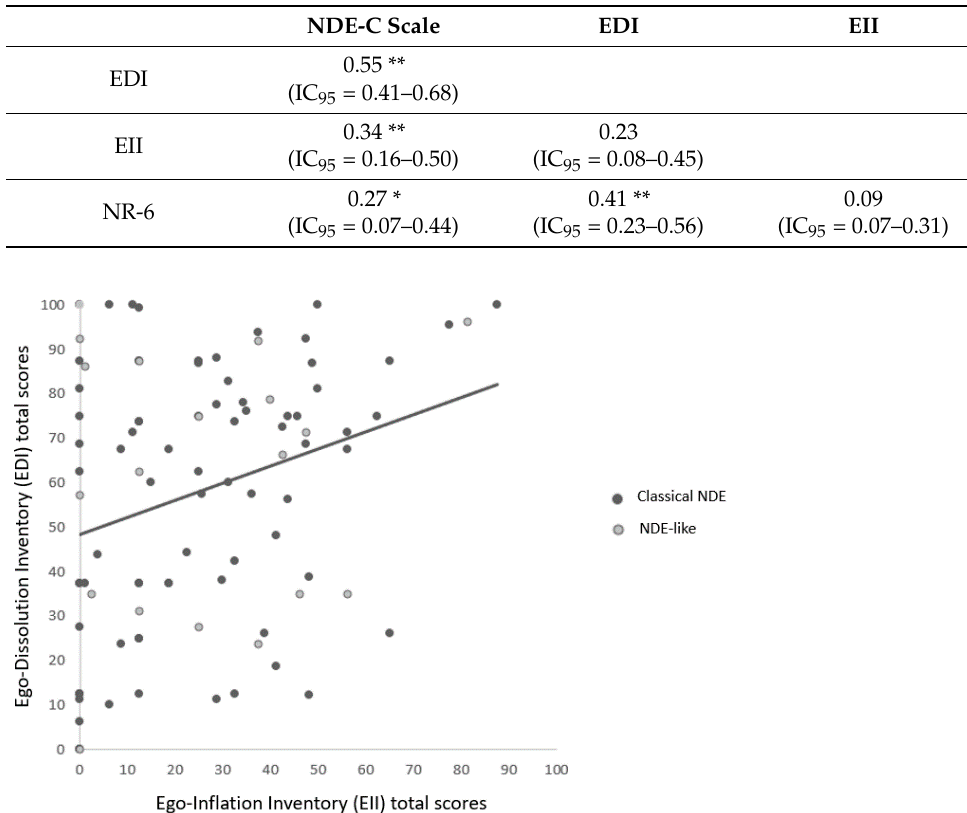
Figure 3. Association between the Ego-Dissolution Inventory (EDI) total scores and the Ego-Inflation Inventory (EII) total scores within the whole sample of experiencers (i.e., classical NDEs as well as NDE-like; r = 0.23, IC 95 = 0.08-.45, p = 0.021). OBE and a sense of unity (i.e., scoring above 0 on these items, thus reflecting the presence of the feature) are reported by 87% and 83% of the experiencers, respectively. Of note, out of the 13 participants who did not experience an OBE, 12 participants scored above 0 on the EDI total score and 9 scored above 0 on the EII total score. EDI total scores were positively correlated with the responses to item 11 (Out-of-body experience) of the NDE-C scale (r = 0.44, IC 95 = 0.19–.53 ; p < 0.001) and with the responses to item 6 (Har- mony/Unity) of the NDE-C scale (r = 0.44, IC 95 = 0.25–0.58 ; p < 0.001). 4. Discussion The present study sought to retrospectively explore the frequency and intensity of the experience of ego dissolution and inflation during NDEs. We observed higher EDI total scores compared with EII total scores in our sample of experiencers. Indeed, higher EDI total scores were more common than low EDI total scores, whereas it was the opposite trend for the EII: low EII total scores were more common than higher EII total scores. The results also revealed that higher scores of NDE ‘richness’ were associated with higher EDI total scores. In other words, the richness of the NDE was strongly (r = 0.55) associated with the subjective intensity of the experience of ego dissolution. Interestingly, the expe- rience of ego dissolution retrospectively reported by our participants is rather intense on average (median of 67/100 on the EDI) and comparable to what is reported after ingestion of psychedelics (e.g., 46/100 reported during a DMT-induced psychedelic experience in [23]; 74/100 reported after a 5-MeO-DMT-induced psychedelic experience in [34]; 41/100 reported after lysergic acid diethylamide [LSD] in [3]; 52/100 reported after psilocybin in- take in [35]). However, no direct comparison regarding the experience of ego dissolution between NDE and drug-induced psychedelic experiences has been carried out yet. As a matter of fact, it would be interesting to directly compare the sense of self experienced in NDEs and psychedelic experiences using a sample of people who experienced both types of experiences. Moreover, we observed that the intensity of the experience of ego dissolu- tion was positively correlated with the sense of harmony/unity experienced during the